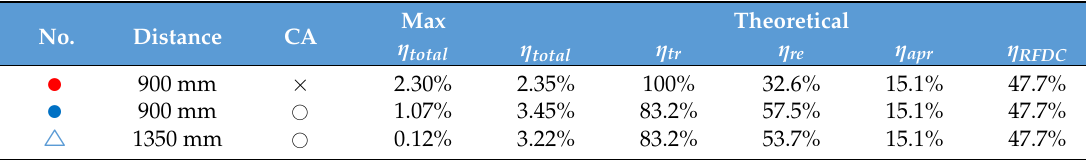
Table 4. Comparison of measurement results, transmission efficiency to theoretical efficiency in respective conditions: 900 mm without CA, 900 mm with CA, and 1350 mm with CA